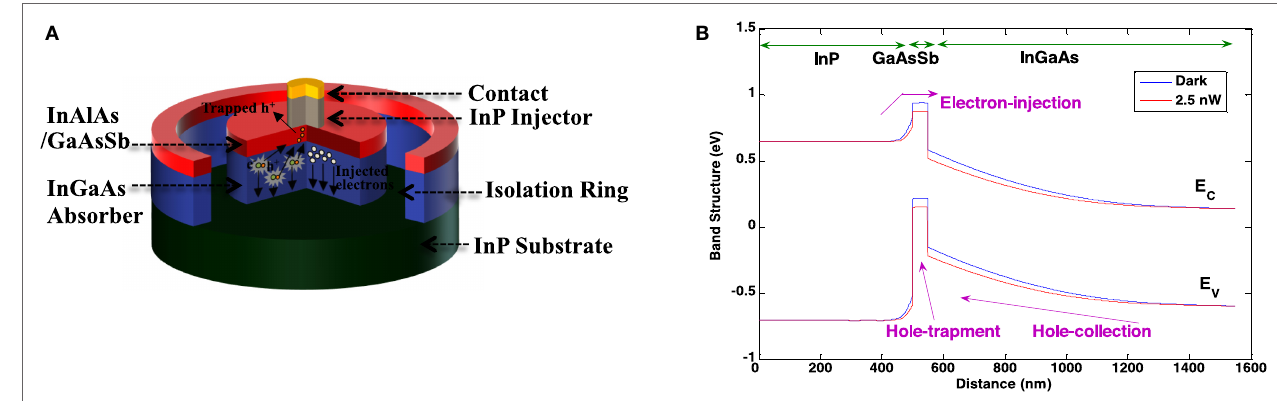
FiGURe 3 | (A) The schematic diagram with a cross section showing the operation mechanism (B) the band diagram through the central axis as a function of depth: in darkness (blue), and under illumination (red) for an electron-injection detector. The InAlAs layer is not included in (B)